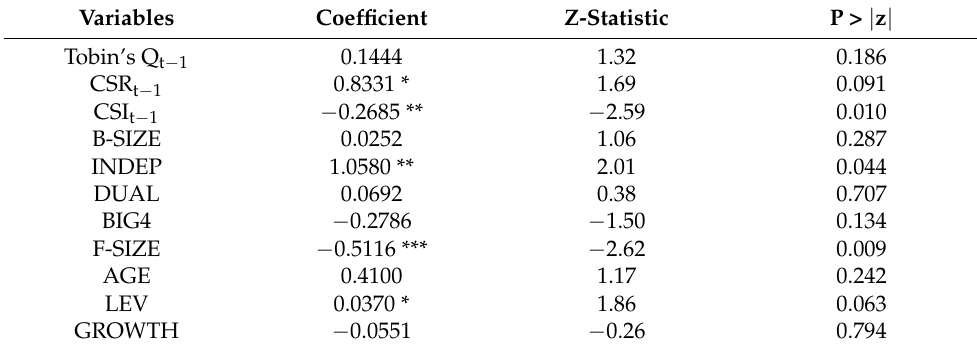
Table 5. VAR estimation